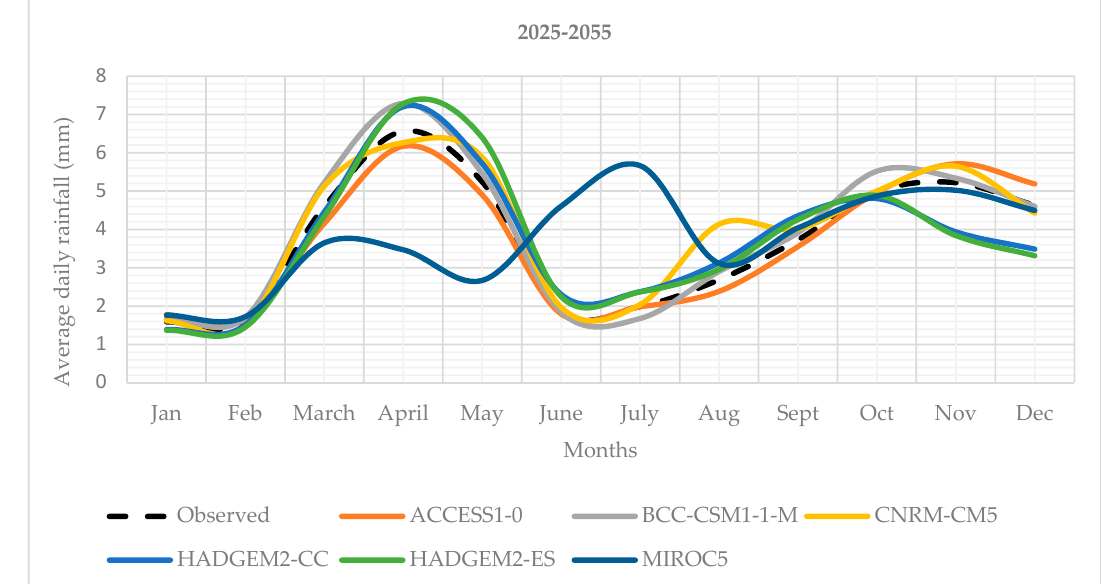
Figure 6. Climate change prediction of daily average rainfall for 2025–2055.